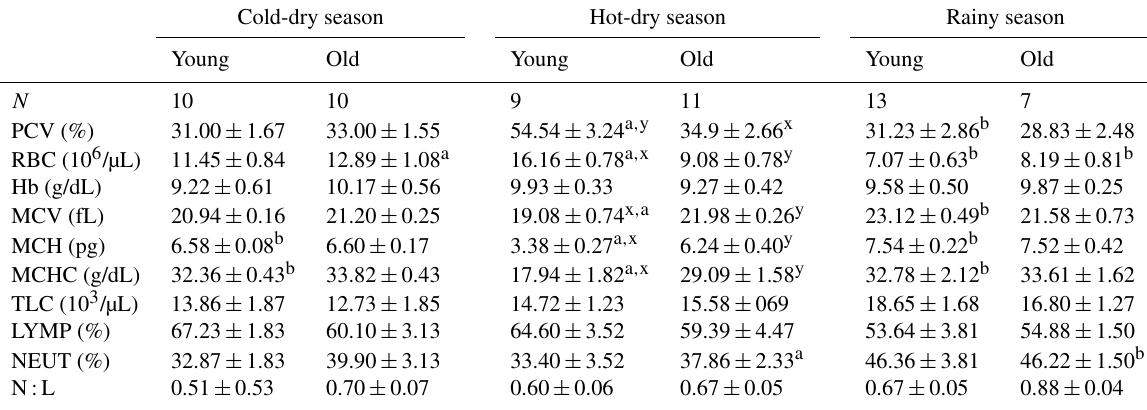
Table 5. Effect of season on haematological parameters of younger (1–2 months) and older (3–4 months) Red Sokoto goat kids. Cold-dry season